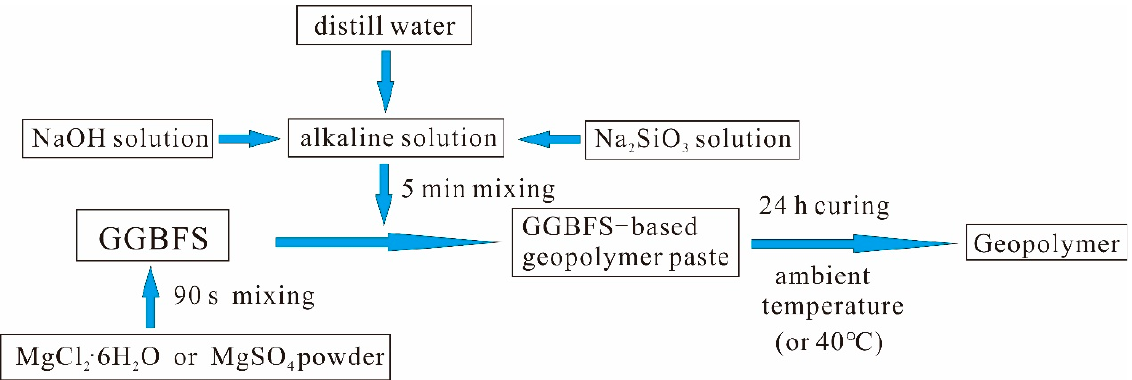
Figure 2. Preparation of GGBFS-based geopolymer.